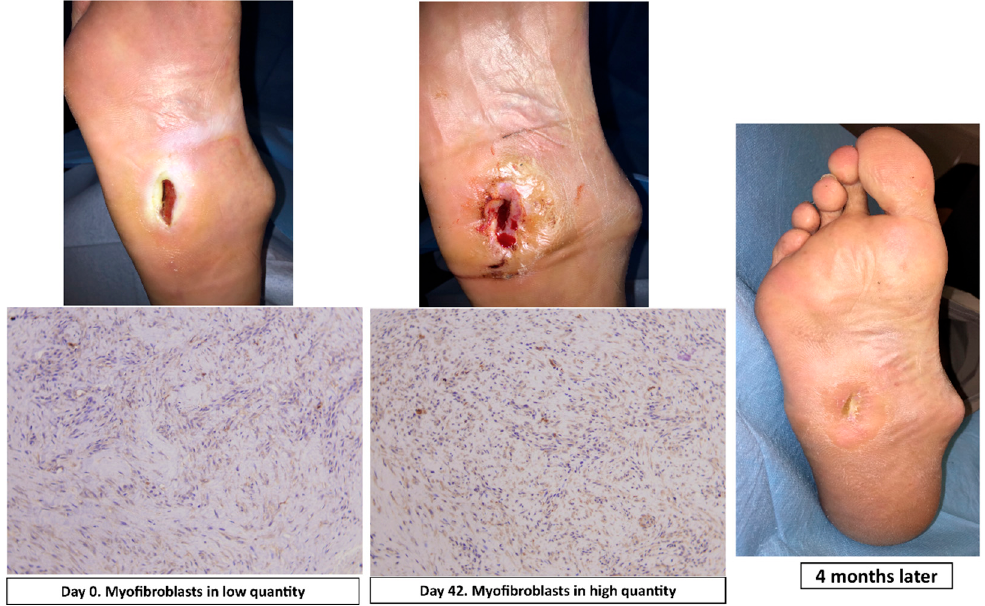
Figure 3. Actin staining (magnification, × 10) at day 0 and day 42, clinical situation and progression of healing in a patient of surgical group.